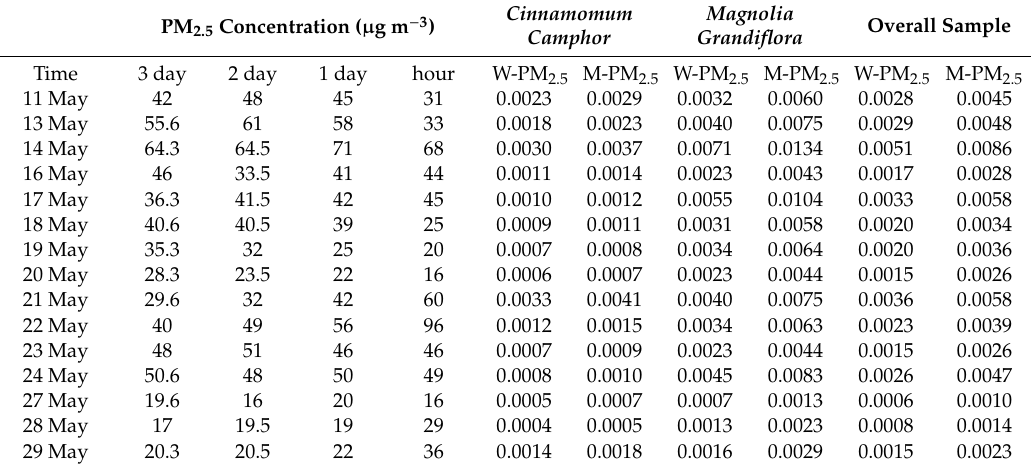
Table 1. PM 2.5 adsorption by sample leaves with di ff erent durations of PM 2.5 concentration.